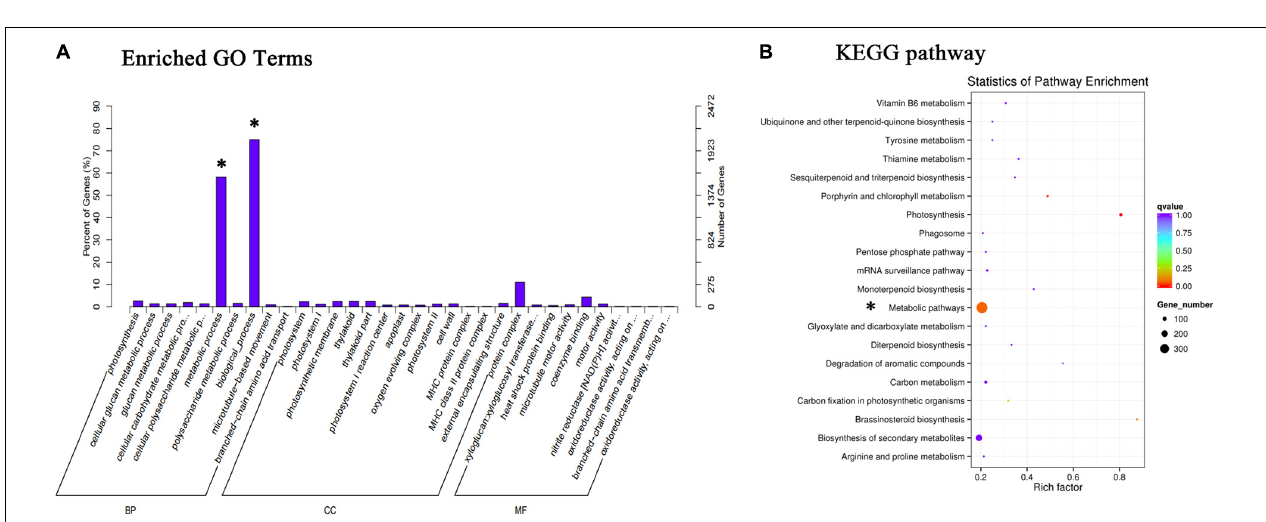
FIGURE 3 | GO and KEGG were used to analyze the pathway of significant changes in S4. (A) Different expression genes were annotated and enriched with the GO database. (B) Metabolic pathways with different changes annotated by KEGG database. Asterisk marks changes in metabolic pathways.